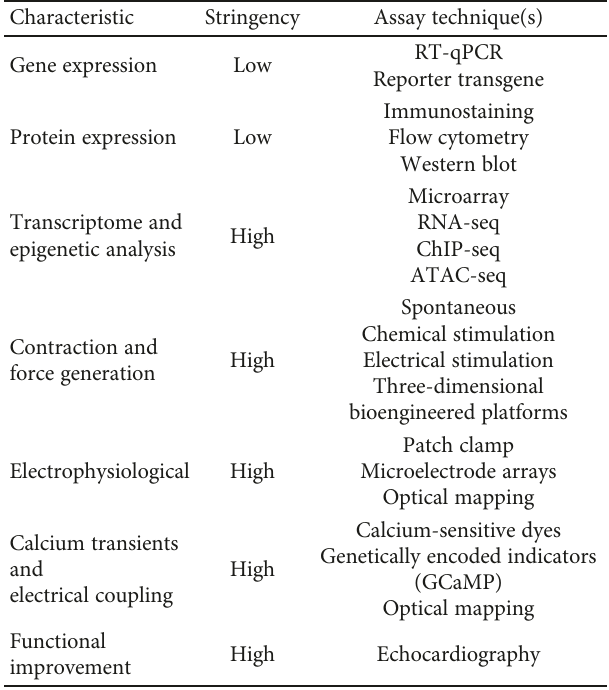
Table 3: Criteria to evaluate reprogramming e ffi ciency. Adapted from Addis and Epstein